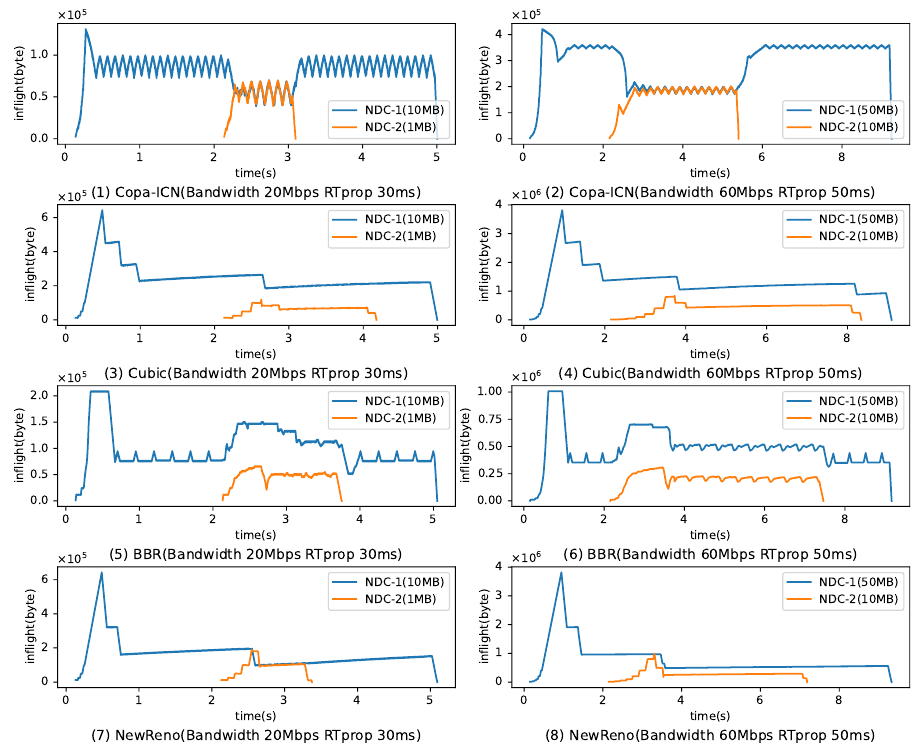
Figure 6. Variation of inflight over time for different factors (algorithm, bottleneck bandwidth, RTprop, and NDC